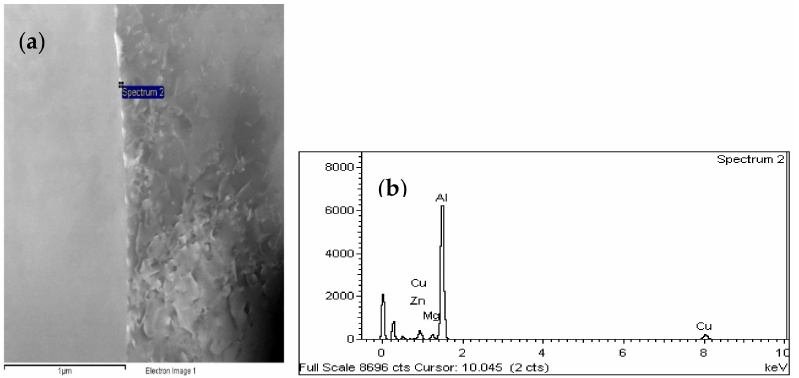
Figure 6. The morphology of AlCuMg particle precipitated along the grain boundary ( a ) and the EDS results ( b